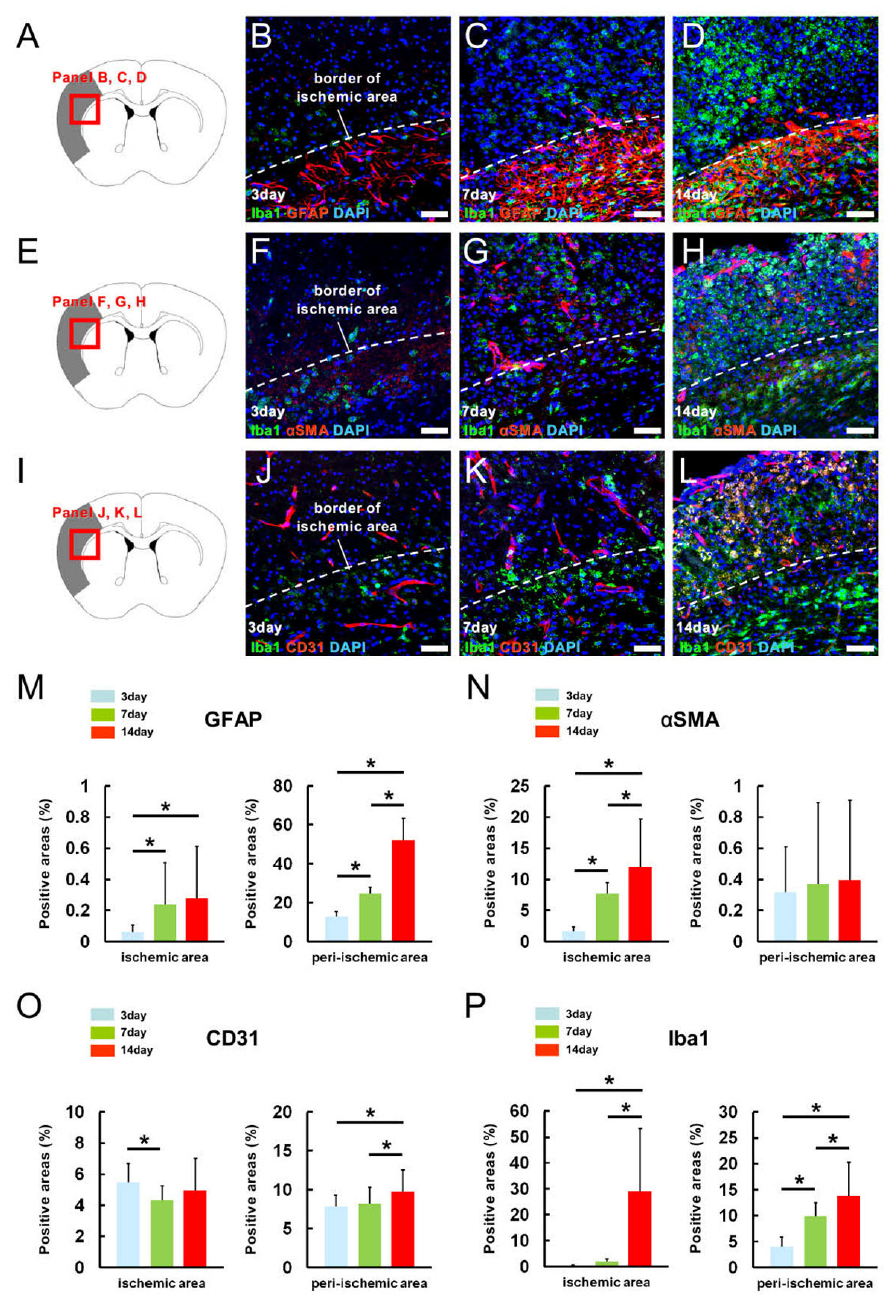
Figure 2. MG, AC, PC, and EC localizations and expression patterns in pathological brain samples. Double immunohistochemical staining ( A – L ) for Iba1/GFAP [Iba1 (( B – D ): green); GFAP (( B – D ): red); DAPI (( B – D ): blue)], Iba1/ α SMA [Iba1 (( F – H ): green); α SMA (( F – H ): red); DAPI (( F – H ): blue)], and Iba1/CD31 [Iba1 (( J – L ): green); CD31 (( J – L ): red); DAPI (( J – L ): blue)] in mice after is- chemic stroke. Positive areas expressing GFAP ( M ), α SMA ( N ), CD31 ( O ), or Iba1 ( P ) were inves- tigated within the ischemic and peri-ischemic areas 3, 7, and 14 days poststroke. Statistical analysis was performed using one-way ANOVA, followed by Bonferroni post-hoc tests (( M – P ); 27 data points (3 points/section, 3 sections/brain, obtained from 3 mouse brains) were used for this analy- sis). * p < 0.05 among poststroke animals at 3, 7, and 14 days after MCAO. Scale bars: 50 µm ( B – D , F – H , J – L ). Abbreviations: AC, astrocyte; α SMA, alpha-smooth muscle actin; DAPI, 4’,6-